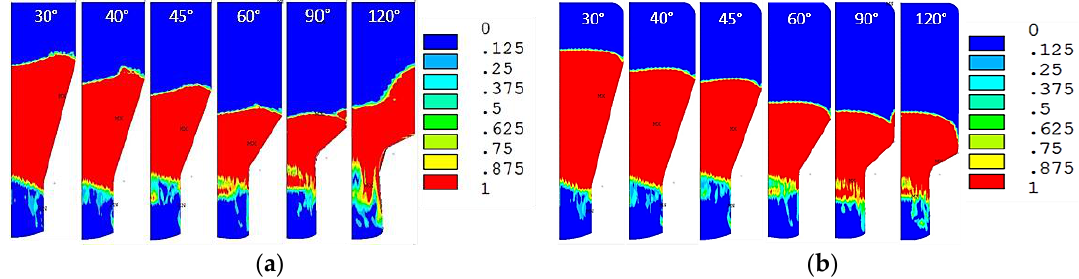
Figure 10. Stress state ratio distribution of ( a ) displacement-load model and ( b ) pressure-load model at 2α = 30°, 40°, 45°, 60°, 90° and 120°.